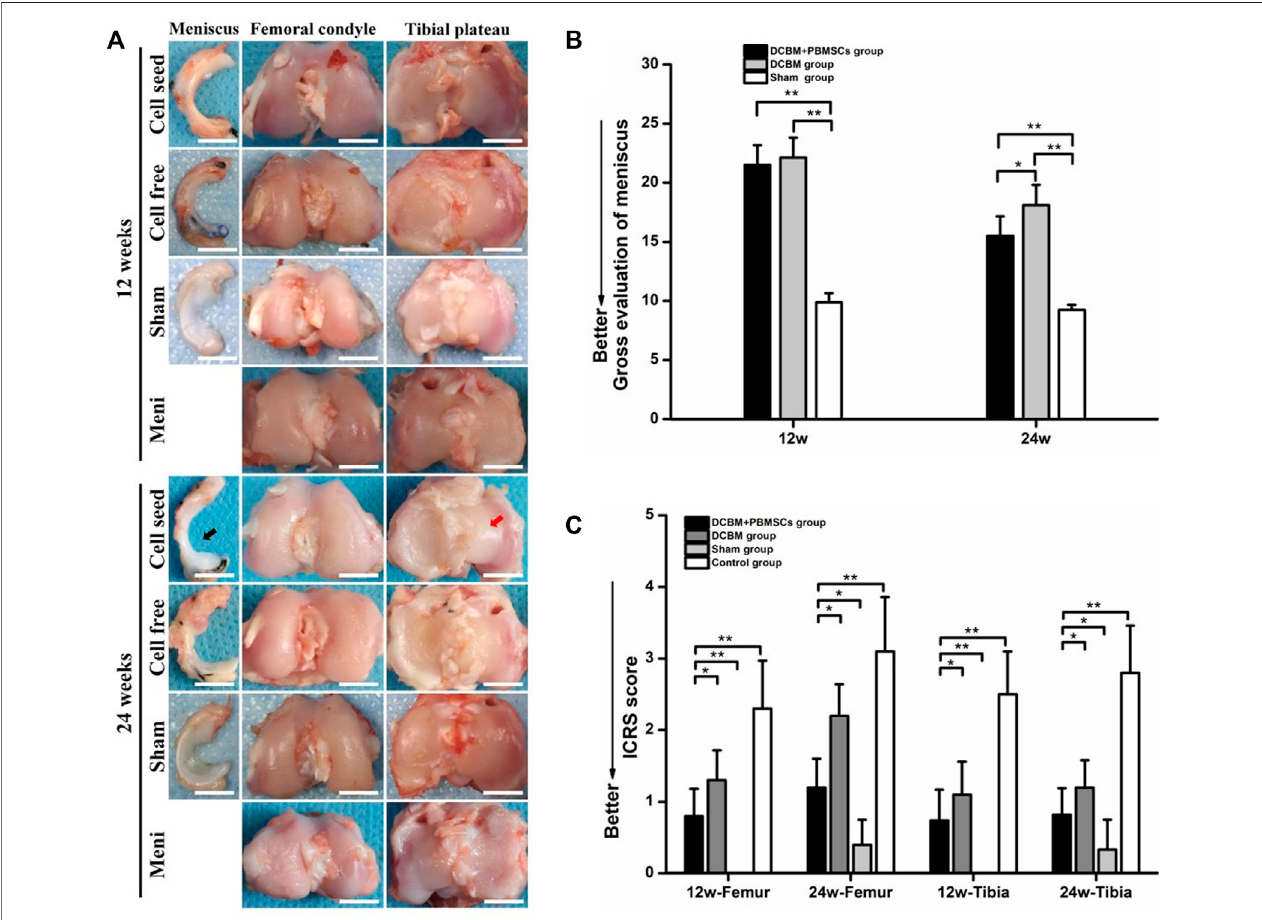
FIGURE 6 | (A) Macroscopic observations and quantitative evaluation of (B) meniscus and (C) cartilage at 12 and 24 weeks postoperatively. Black arrow showed the DCBM + PBMSCs group gained mature meniscus which was similar to normal meniscus after 24 weeks. Red arrow showed smooth articular surface. Scale bar = 200 μ m, * p < 0.05, ** p <